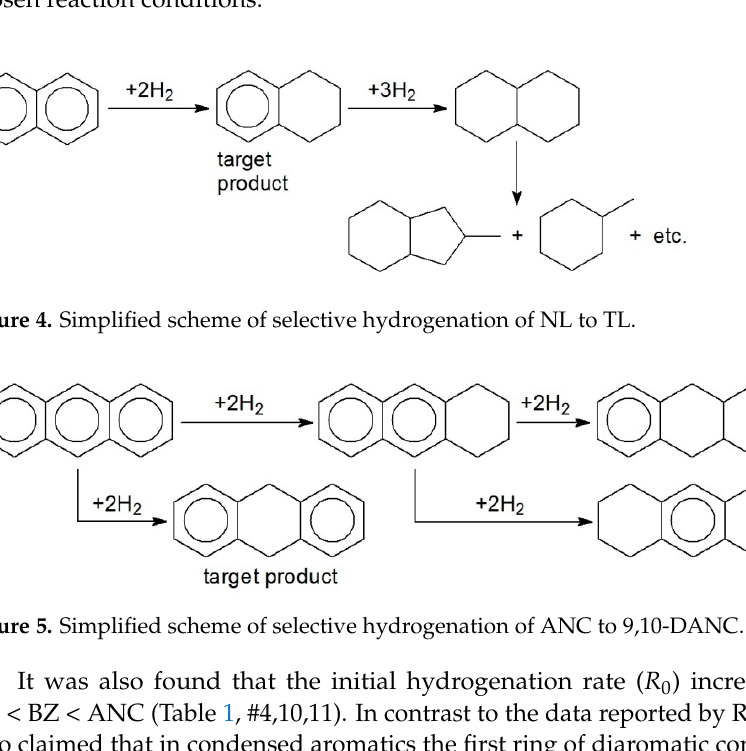
Figure 5. Simplified scheme of selective hydrogenation of ANC to 9,10-DANC.